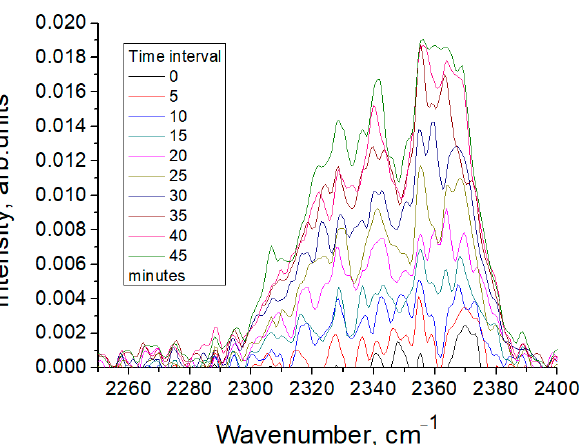
Figure 8. Profiles of the libration band of dried kaolinite samples depending on the time of adsorption of water vapor from air.